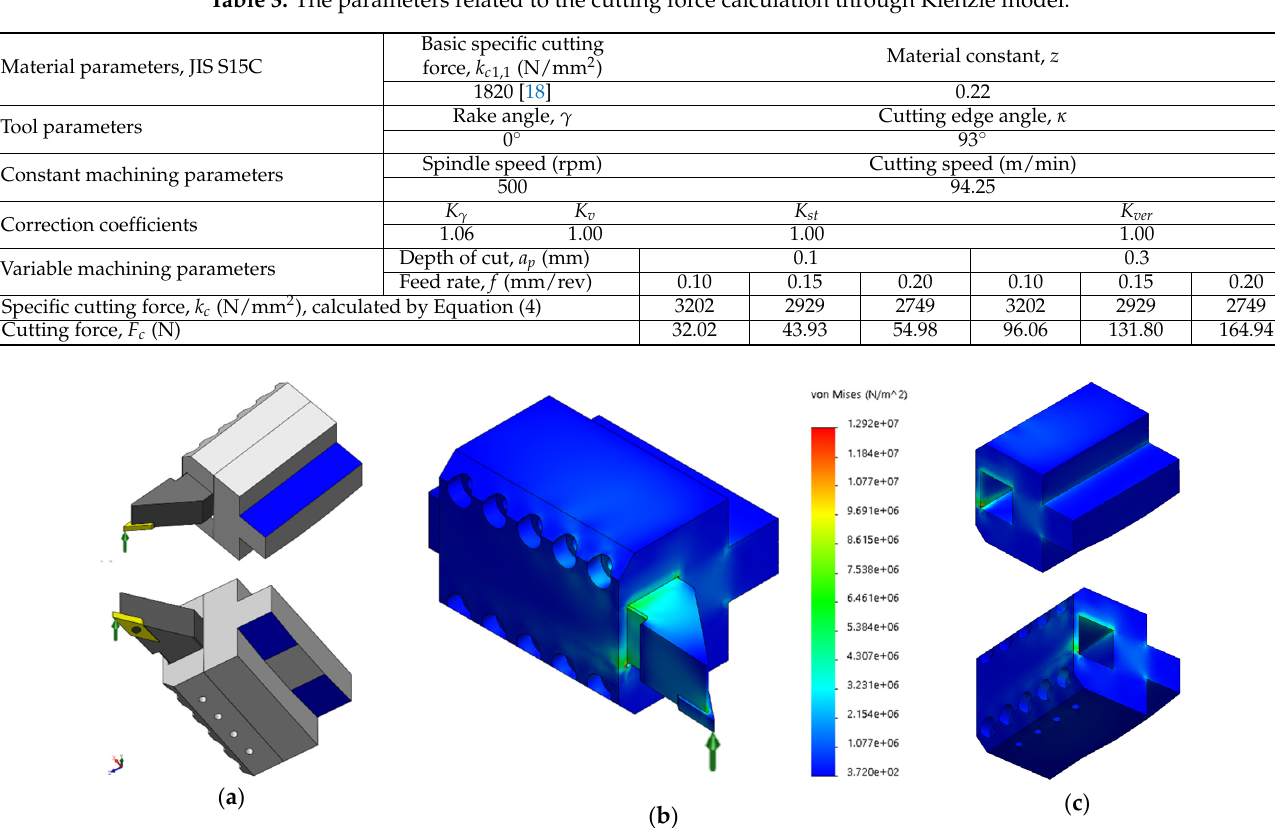
Figure 4. The stress field of the smart tool holder subject to the cutting force based on finite element simulation: ( a ) the fixed boundaries being shown on the blue surfaces; ( b ) the stress field of the combination of the turning tool and the smart tool holder; and ( c ) the backside and front-side views of the stress field of the smart tool holder.